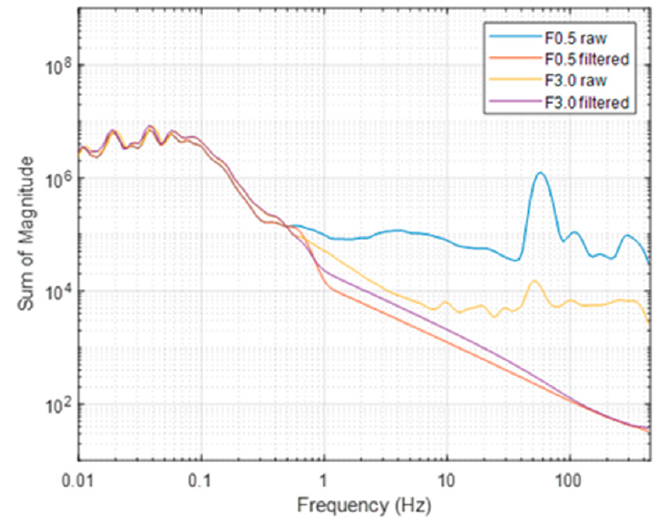
Figure 5. Sum of power of the scalograms for each frequency of both raw and filtered data flights.